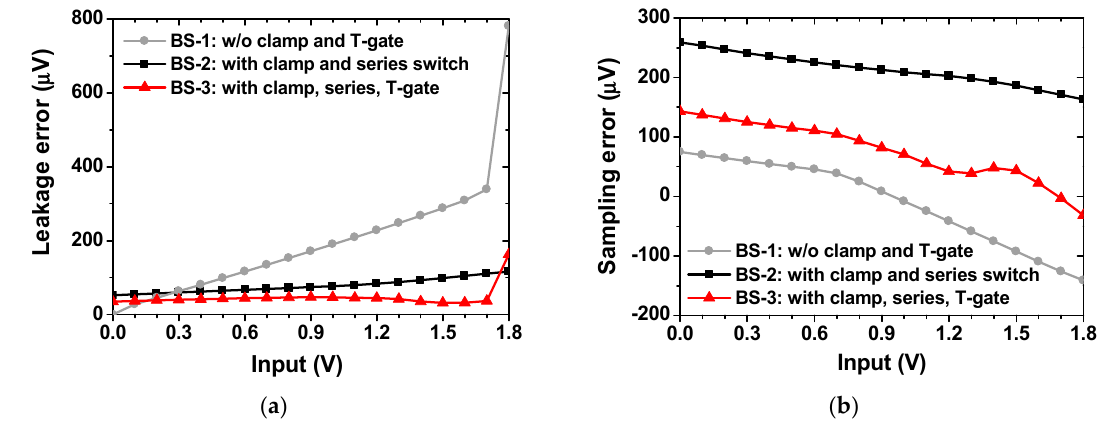
Figure 18. Comparison of three bootstrap sampling switches for ( a ) leakage-induced error and ( b ) sampling error as a function of the input.